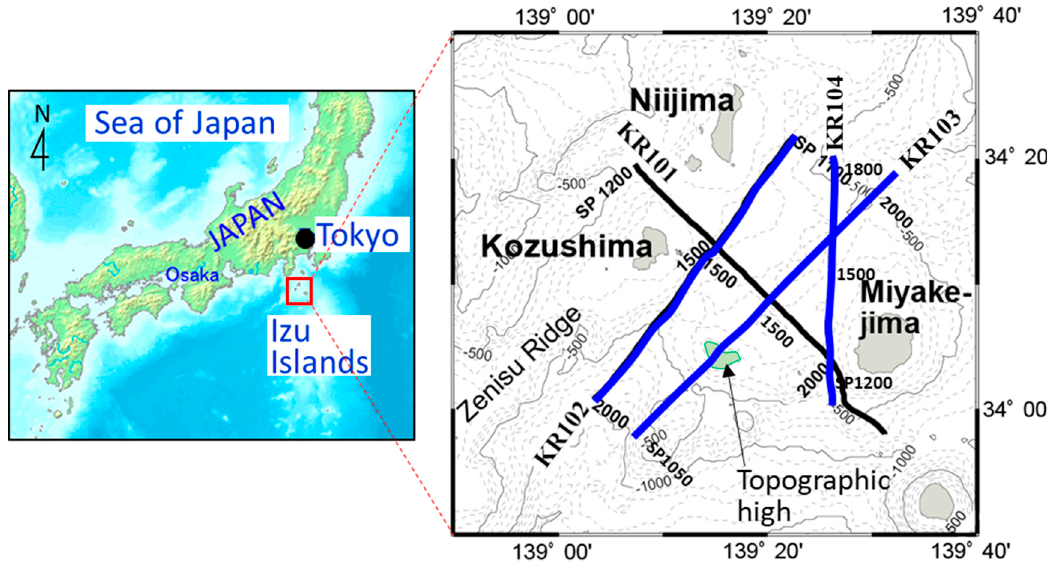
Figure 1. Study area and seismic reflection survey lines (modified the previous study [3]). Four lines of seismic reflection data were collected during the KR00-08 Cruise of R/V Kairei by Japan Agency of Marine-Earth Science and Technology (JAM STEC) in 2000. The three thick blue lines represent seismic lines used in this study. The 4-digit numbers show Shot Point (SP) number.